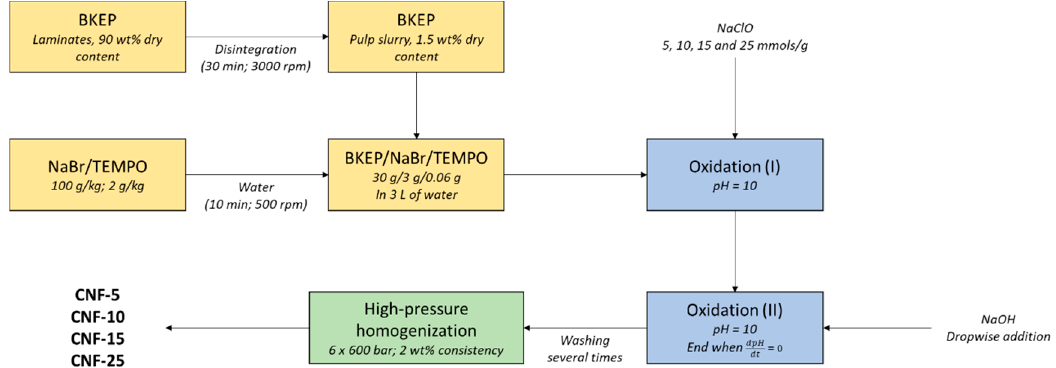
Figure 1. Experimental diagram of the production of TEMPO-oxidized cellulose nanofibers (CNF).